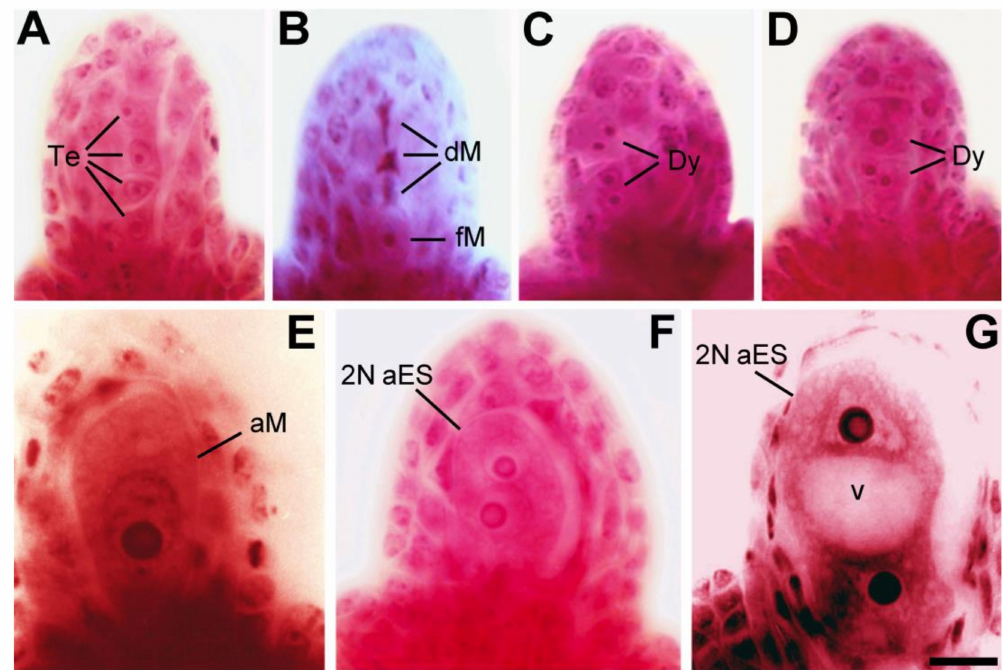
Figure 2. Alfalfa ovules analyzed by stain-clearing techniques, showing a linear tetrad of haploid megaspores (Te) derived from regular meiotic division (panel A ), a chalazal regularly reduced functional megaspore (fM) along with three degenerating haploid megaspores (dM) (panel B ), SDR-type dyads of megaspores (Dy) produced by the omission of cytokinesis after the second meiotic division (panels C and D ), an enlarged uninucleate apomeiotic megaspore of the FDR-type (aM) derived from the lack of first meiotic division (panel E ), and FDR-type unpolarized and polarized with central vacuole (v) binucleate apomeiotic embryo sacs (2N aES) (panels F and G ) (these micrographs of ovules have been retrieved from [13,15,17,19] and graphically elaborated and standardized for magnification and micropylar (top) to chalazal (bottom) orientation by using Adobe Photoshop image analysis software; Bar = 10 µ m in A – D and 5 µ m in E – G